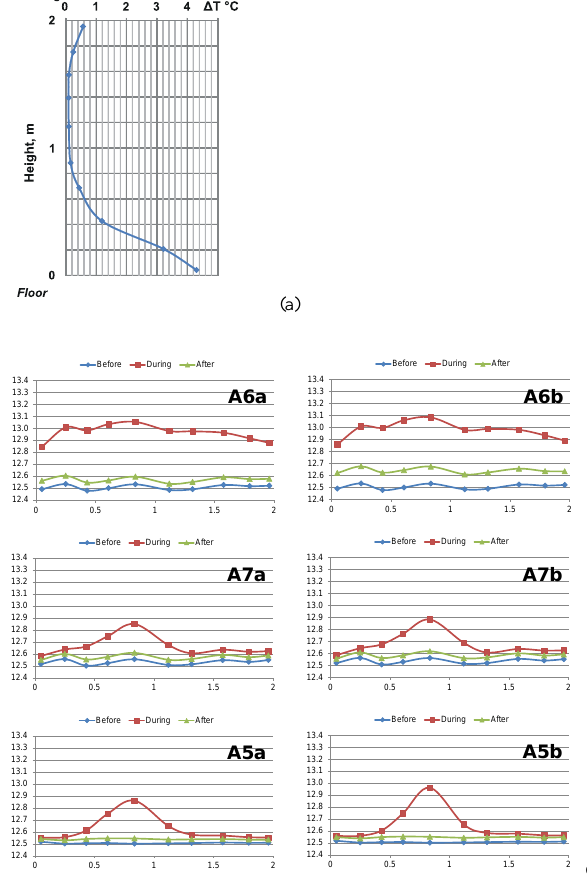
Figure 14: (a) The difference Δ T = T h – T 0 of the average temperatures in 24 hours during ( T h ) and 12 hours before ( T 0 ) a Figure 14. (a) The difference (cid:49)T = T h − T 0 of the average temper- heating experiment with a vertical bar AIII (experiment, A3). (b) The average temperatures on a horizontal bar AIII in 12 hours before (blue), 24 hours during (red), and 12 hours after a heating experiment at 2-m (top), 1.5-m (middle), and 1- atures in 24h during ( T h ) and 12h before ( T 0 ) a heating experiment m (bottom) heights (experiments A6a, A6b, A7a, A7b, A5a, and A5b, correspondingly). with a vertical bar AIII (experiment, A3). (b) The average temper- atures on a horizontal bar AIII in 12h before (blue), 24h during (red), and 12h after a heating experiment at 2m (top), 1.5m (mid- dle), and 1m (bottom) heights (experiments A6a, A6b, A7a, A7b, A5a, and A5b,